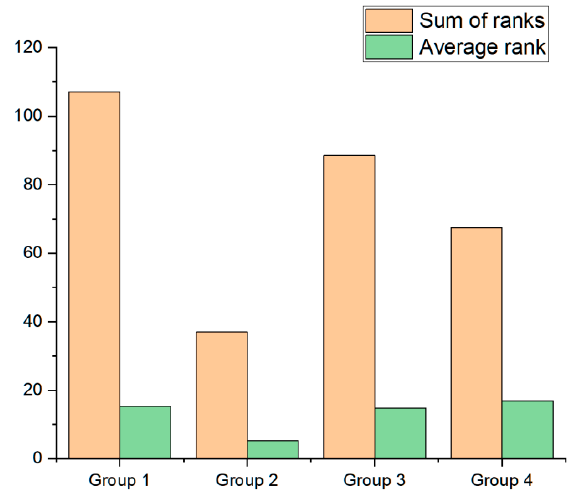
Figure 8. Ranks of Kruskal–Wallis analysis.